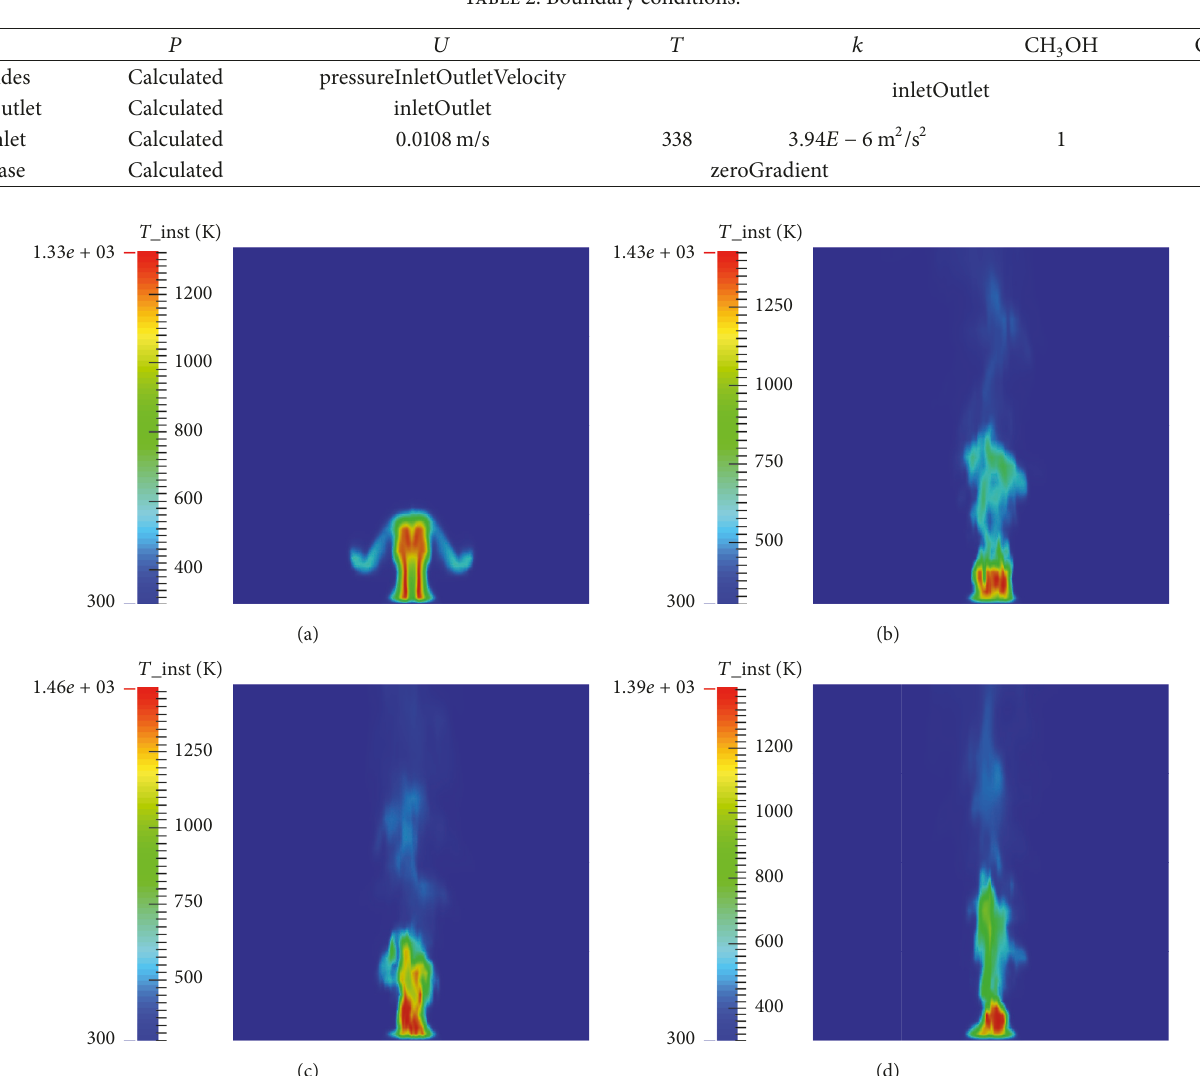
Figure 3: Instantaneous temperature contours at the middle plane of the domain for mesh C at different times (a) 1s, (b) 5 s, (c) 10s, and (d) 20